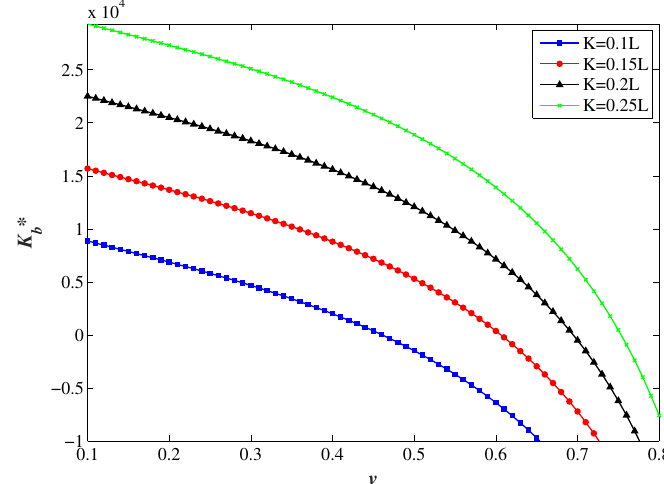
Figure 5. Optimal security investment allocation with intrinsic